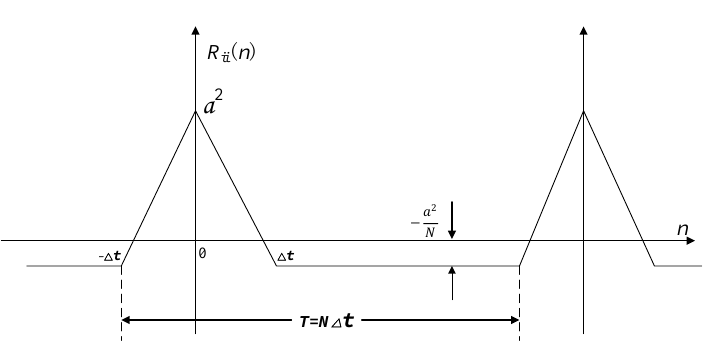
Figure 5. The self-correlation function of random sequence.